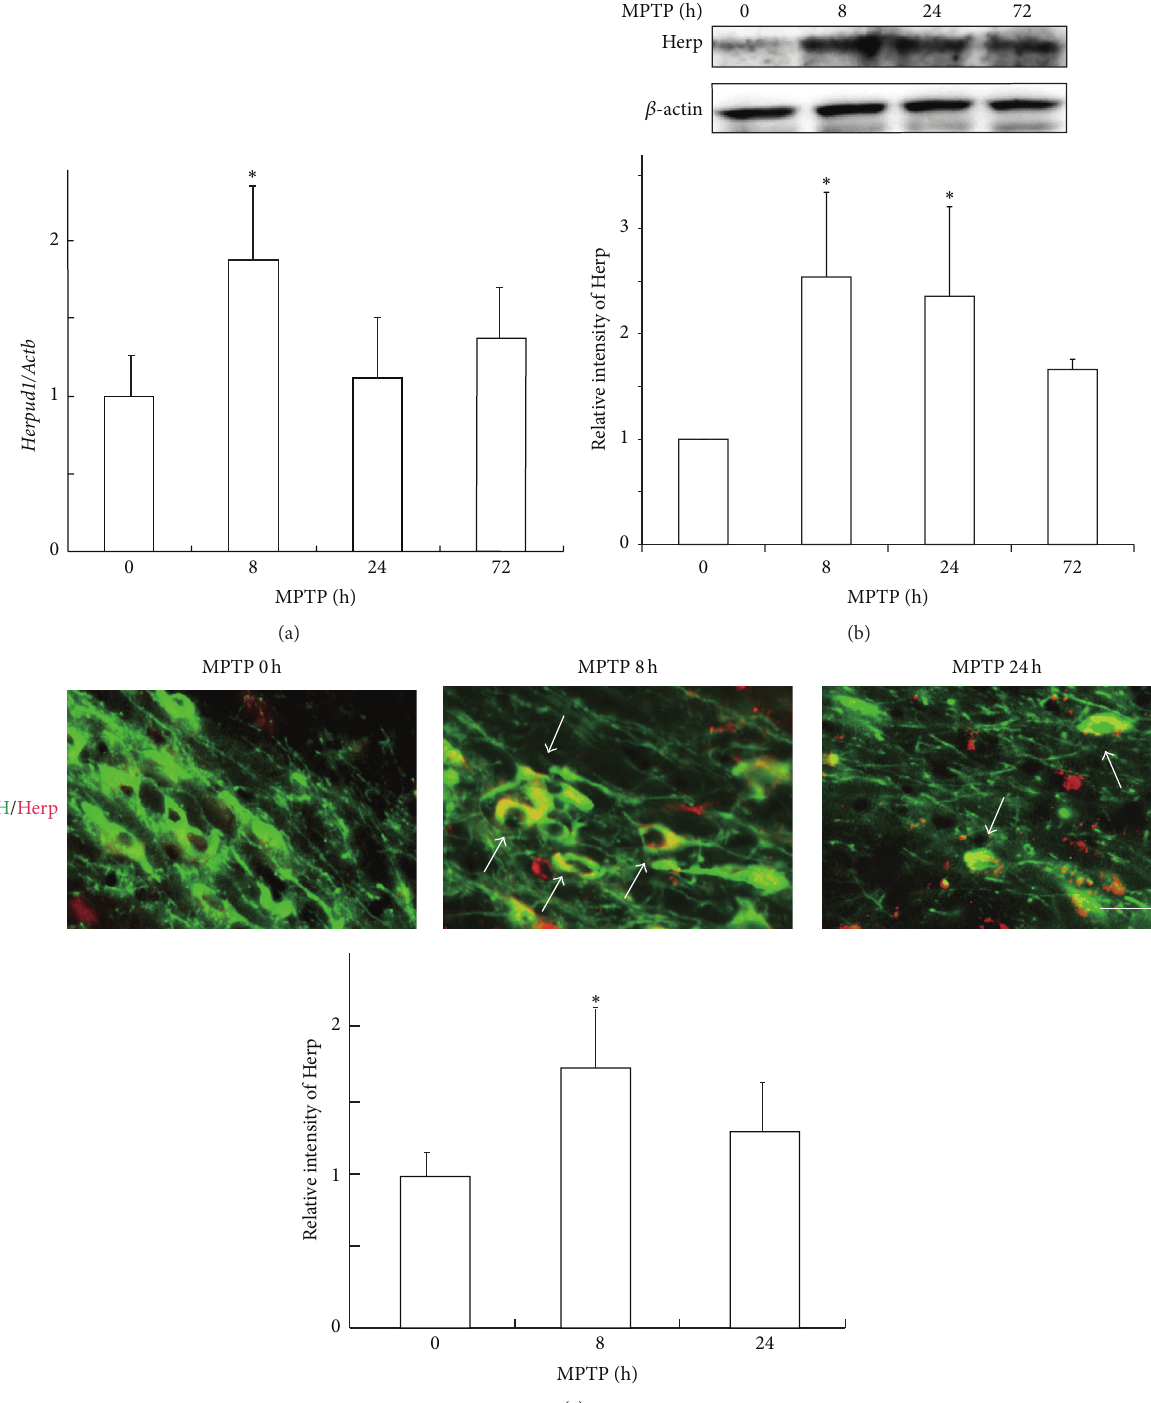
Figure 1: Expression of Herp after MPTP administration. (a) qRT-PCR. Herpud1 +/+ mice were injected with MPTP, and the total RNA (1 𝜇 g), which was extracted from the ventral midbrain, was subjected to qRT-PCR. Each value shown is the mean ± the standard deviation (SD) ( 𝑛 = 4 ), and the value derived from the mice without MPTP injection is designated as one. ∗ 𝑃 < 0.05 , compared to mice without MPTP administration. (b) Western blots. Herpud1 +/+ mice were injected with MPTP, and protein samples (30 𝜇 g) extracted from the CPu were subjected to western blotting with anti-Herp and anti- 𝛽 -actin antibodies. Each value shown is the mean ± SD ( 𝑛 = 4 ), and the value derived from the mice without MPTP administration is designated as one. ∗ 𝑃 < 0.05 , compared to mice without MPTP administration. (c) Immunohistochemistry. Herpud1 +/+ mice were injected with MPTP and perfused with 4% paraformaldehyde at the indicated times. Brain sections, including sections with the SNpc, were analyzed by immunohistochemistry with anti-Herp and anti-TH antibodies. Arrows indicate Herp expression in the TH-positive dopaminergic neurons after MPTP administration. Scale bars = 30 𝜇